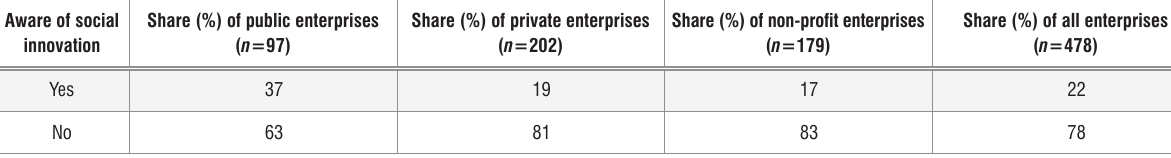
Share (%) of enterprises aware of the term social innovation by enterprise type Aware of social innovation